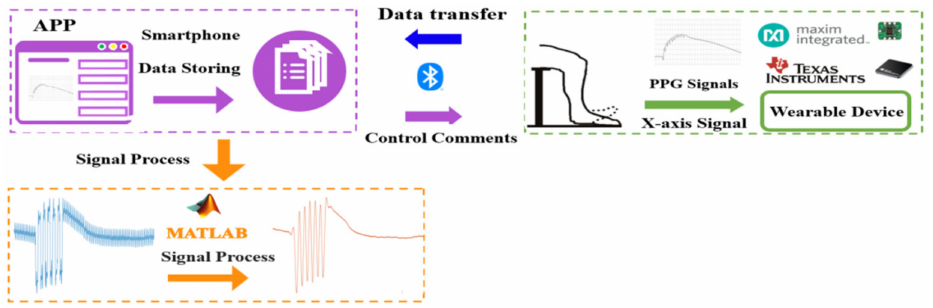
Figure 1. Architecture of the deep vein thrombosis (DVT) examination system. APP is the mobile application and PPG is the